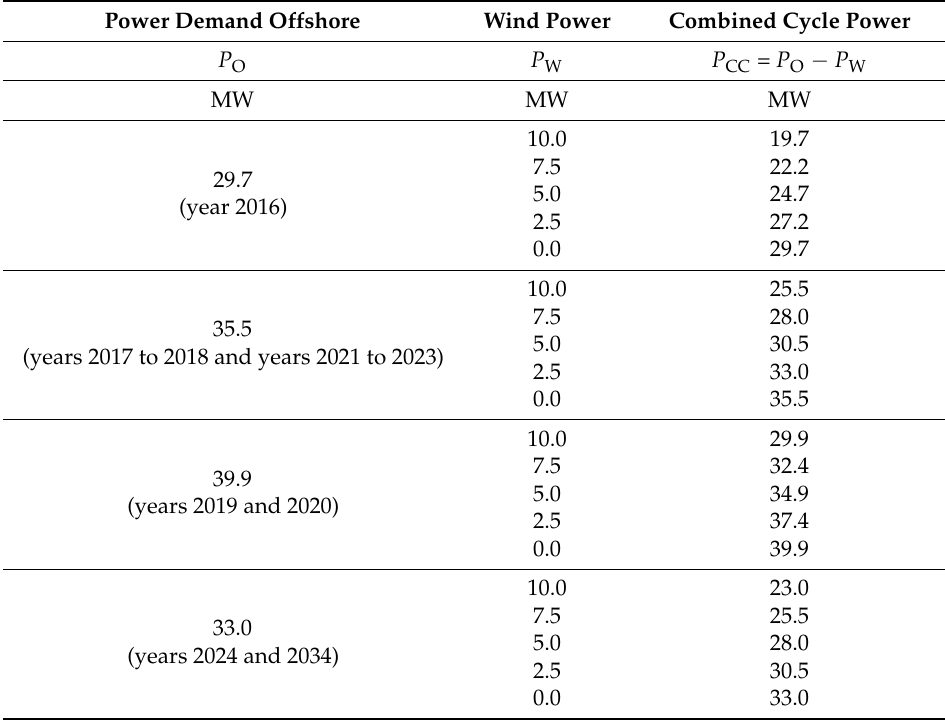
Table 3. Off-design conditions to be tested by the optimisation procedure given a wind power capacity installed of 10